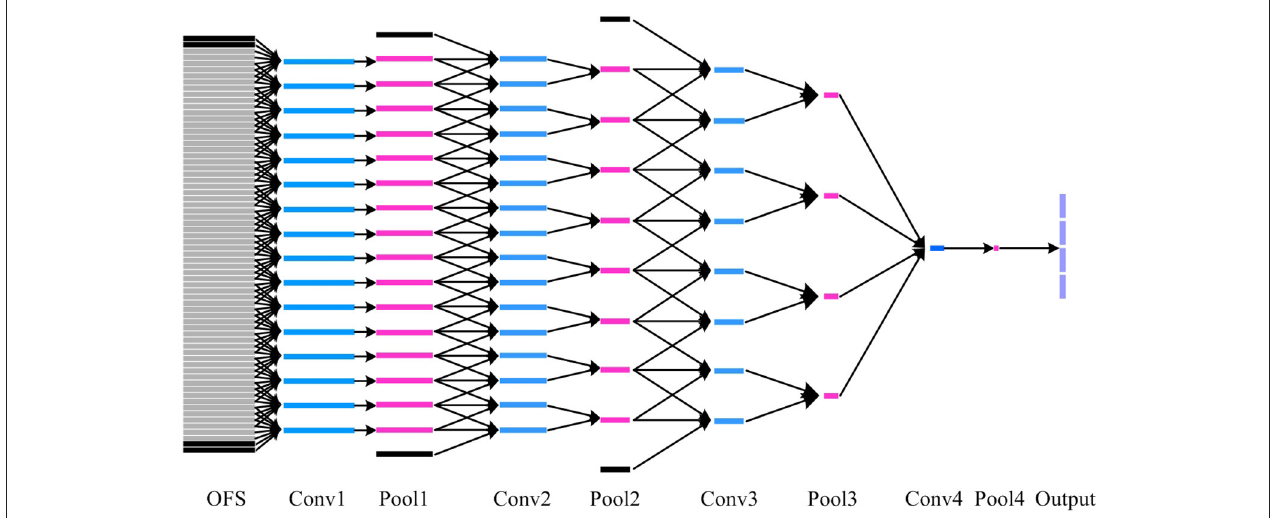
FIGURE 5 | The details of how 3D convolutional kernel in DTSCNN64 process a video clip. The blue, pink and purple box represents convolutional, pooling, and classifying layers, respectively. OFS denote optical flow sequence. The black box indicates the padding image in temporal domain. Each gray box represents an optical flow image. Besides, all parallel blue boxes in the same layer share parameters.